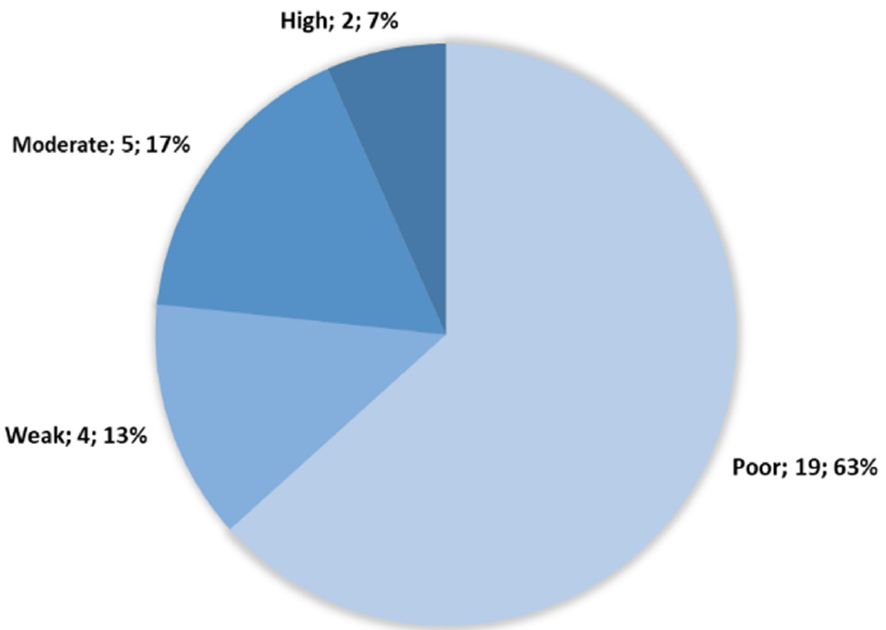
Figure 1. Strain distribution following cBRT clustering and size of each cluster (cluster; number of strains; %). A total of 19 strains were classified as poor early biofilm producers, representing 63% of our strains sample. A total of 4 strains as weak early biofilm producers (13%). A total of 5 as mod- erate early biofilm producers (17%). A total of 2 as high early biofilm producer (7%).